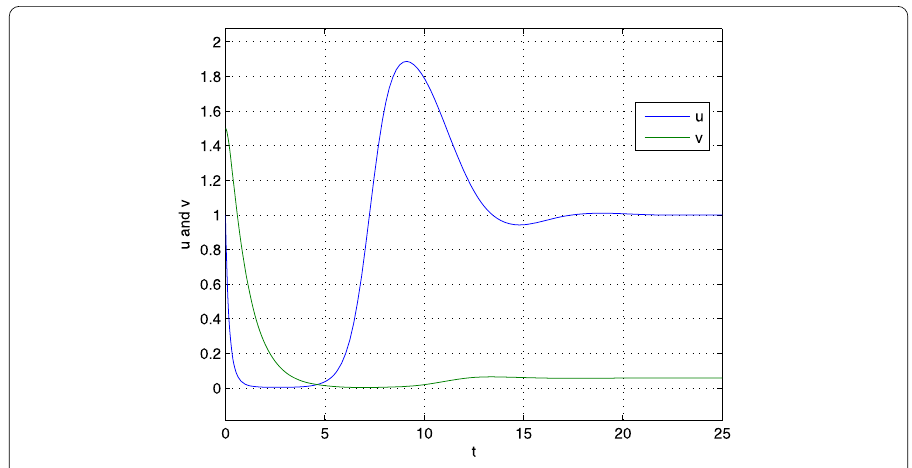
Figure 16 Dynamic behavior of system (1.1) with r 0 = 4, d = 1, a = 1, p = 2, E = 1, m 1 = 1, m 2 = 0.1, c = 0.5, q = 1.1, and k = 5